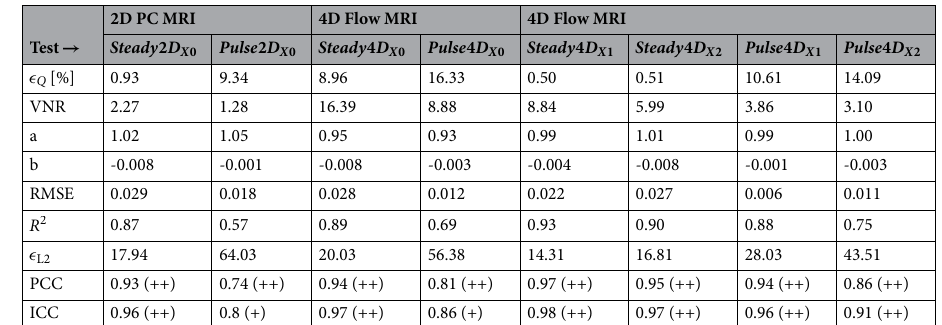
Table 3. Statistical analysis for velocity results. Left: Standard PC MRI protocol. Right: 4D Flow MRI data resolution refinement protocol. X1 resolution refinement 1, X2 resolution refinement 2.